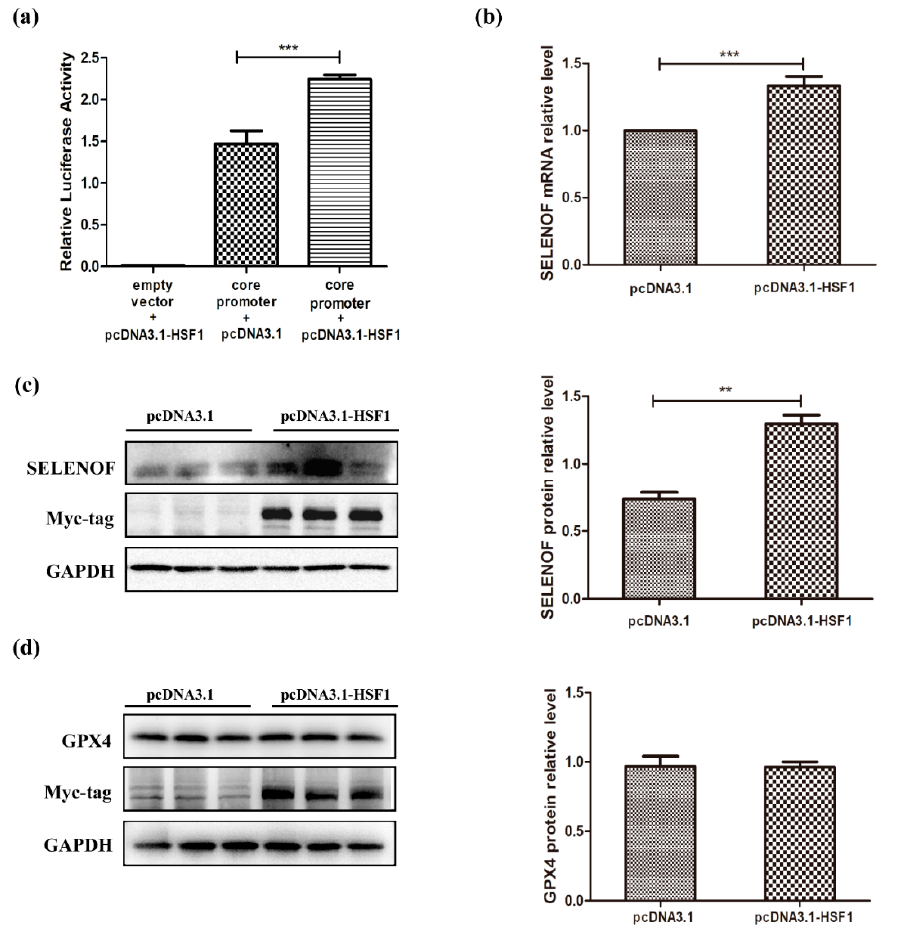
Figure 3. Heat Shock Factor 1 (HSF1) increased SELENOF transcriptional regulation. ( a ) Luciferase reporter activities of SELENOF core positive regulatory element, ( b ) transcriptional levels of SELENOF, protein levels of ( c ) SELENOF and ( d ) GPX4 in control and HSF1 over-expressed HEK293T cells. The empty vector pcDNA3.1 was used as the negative control to be compared with pcDNA3.1-HSF1. In Luciferase reporter assays, the empty vector pGL4.10 was used as the negative control, while the pGL4-818 / -248 was used as core promoter of SELENOF. * p < 0.05, ** p < 0.01 and *** p < 0.001.